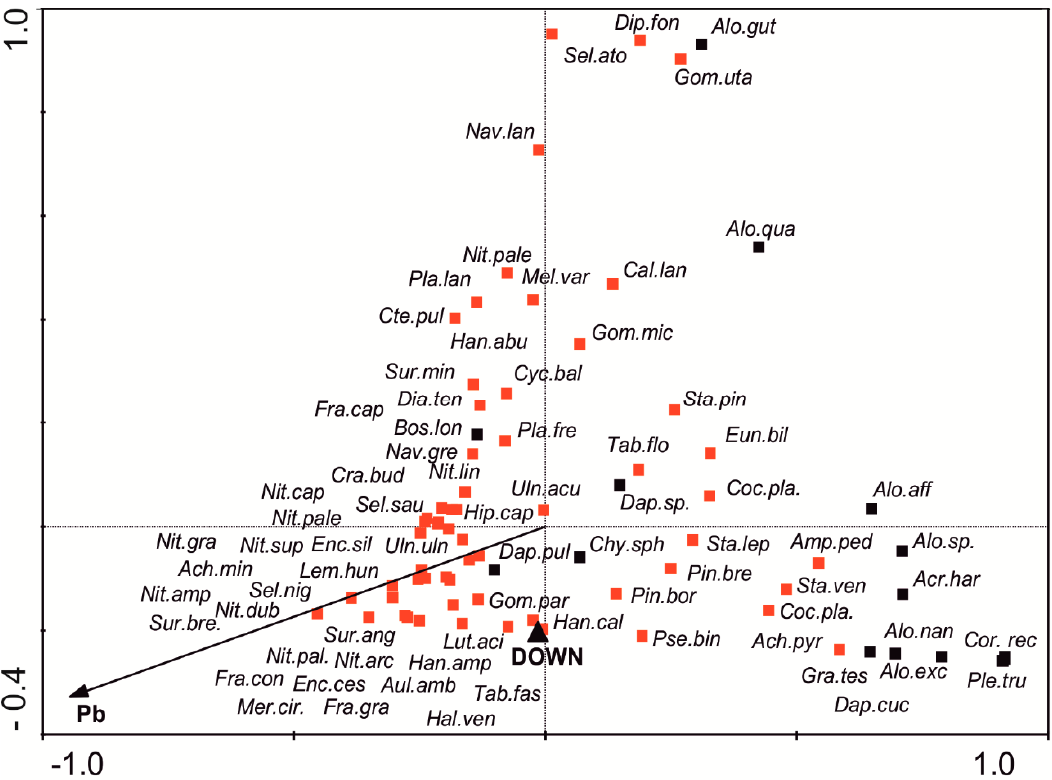
Figure 5. Canonical correspondence analysis (CCA) diagram for diatoms and cladocerans species.